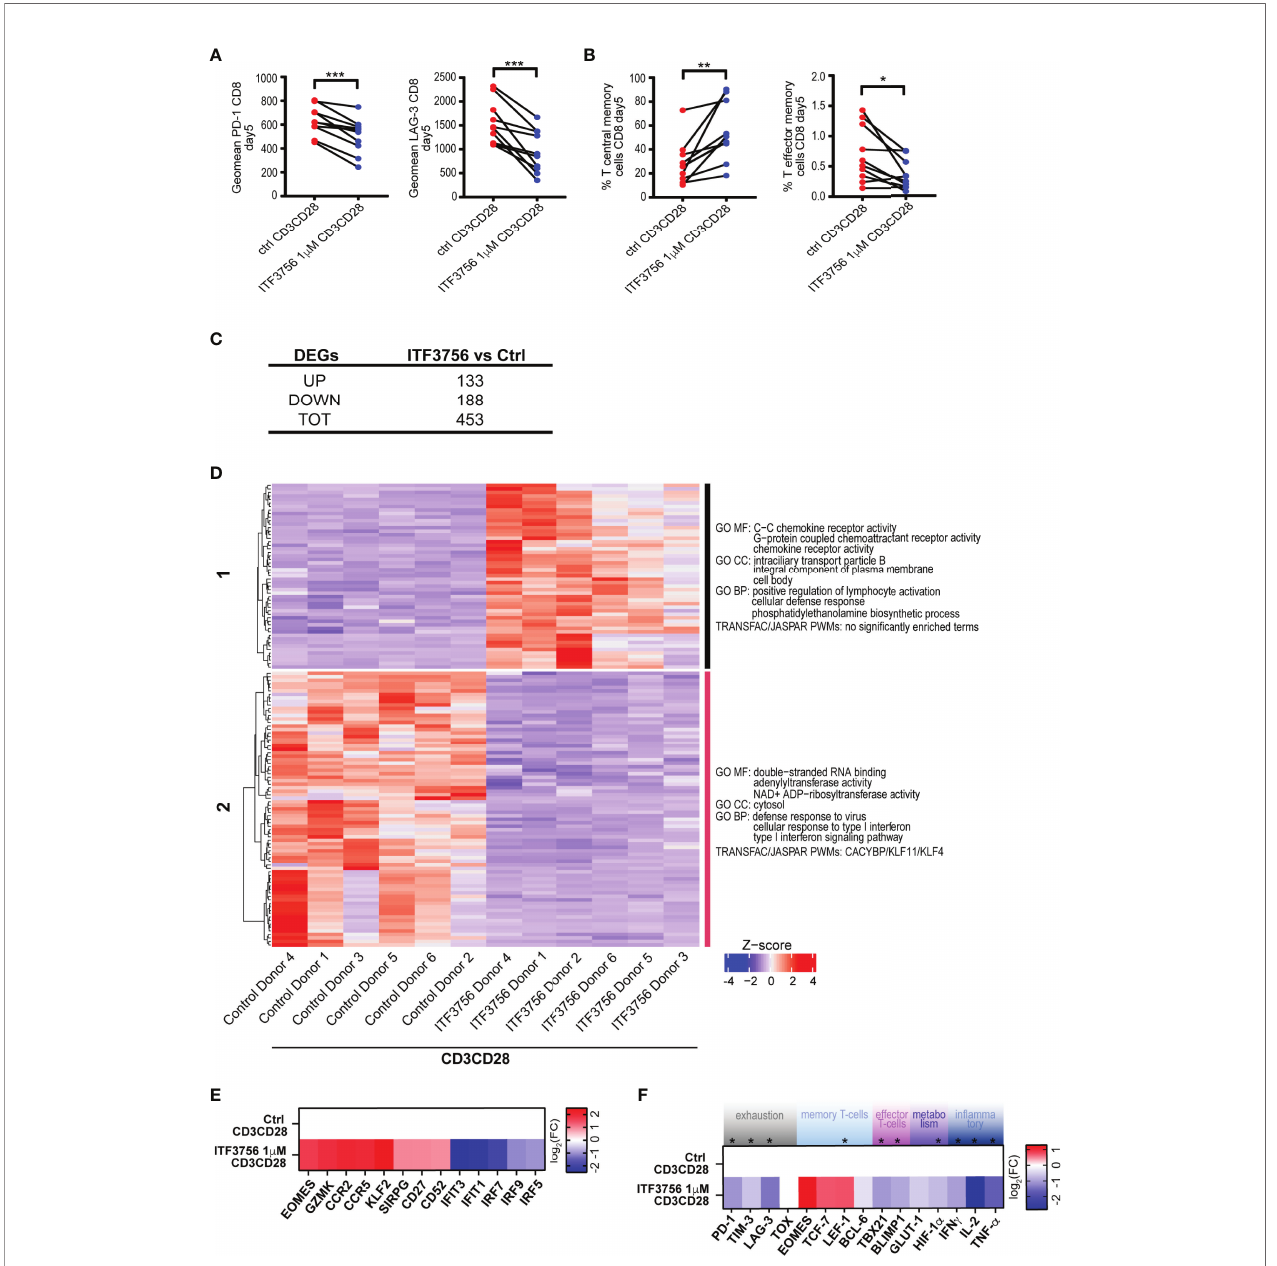
FIGURE 7 | ITF3756 treatment reduced exhaustion and increased T central memory phenotype in CD3/CD28-stimulated CD8 + puri fi ed T-cells during the exhaustion process. Puri fi ed CD8 + T-cells were pre-treated with ITF3756 for 2 hours and then stimulated with anti-CD3/CD28 beads for 3 days followed by another run of stimulation in the presence of the inhibitor for 2 days. Cells were counted at the end of each stimulation period, beads removed, and cells placed in new medium with fresh beads for the next stimulation. At day 5 after stimulation cells were collected and analysed by fl ow cytometry, qPCR and RNASeq. (A, B) Characterization of exhaustion markers and T-cells phenotype was performed by fl ow cytometry. (A) Exhaustion markers (B) T central memory phenotype. Paired t- test analysis of 10 donors at day 5 of exhaustion process is shown *P ≤ 0.05, ** ≤ 0.01, ***< 0.001. Geomean is the geometrical mean fl uorescence intensity. (C – F) Gene expression analysis of mRNA extracted at day 5 by RNASeq and by qPCR in 6 donors. (C) Summary of signi fi cantly differently expressed genes (DEGs). Up- and down- regulated genes were de fi ned as follows: -1< log 2 (Fold change) <1 and padj<0.01. (D) The heatmap shows hierarchical clustering of RNASeq data of CD3/CD28-stimulated CD8 + T-cells treated or not with ITF3756. Gene Ontology of Molecular Function (MF), Biological Processes (BP) and Transcription Factor Binding motif enrichment (TRANFAC/JASPAR PWMs) is reported for each cluster. Top 3 gene sets per clusters are shown. (E) The heatmap shows the modulation of speci fi c genes observed in the RNASeq analysis. Log 2 Fold Changes of ITF3756 modulated genes compared to the untreated control were reported. (F) Real Time qPCR analysis of gene expression of a selected panel of genes known to be involved in T-cells exhaustion, activation and differentiation in 6 donors. The heatmap shows log 2 Fold Changes of ITF3756 modulated genes compared to the untreated control. P values were calculated by Paired t-test analysis. Asterisks indicate statistically signi fi cant changes (P ≤